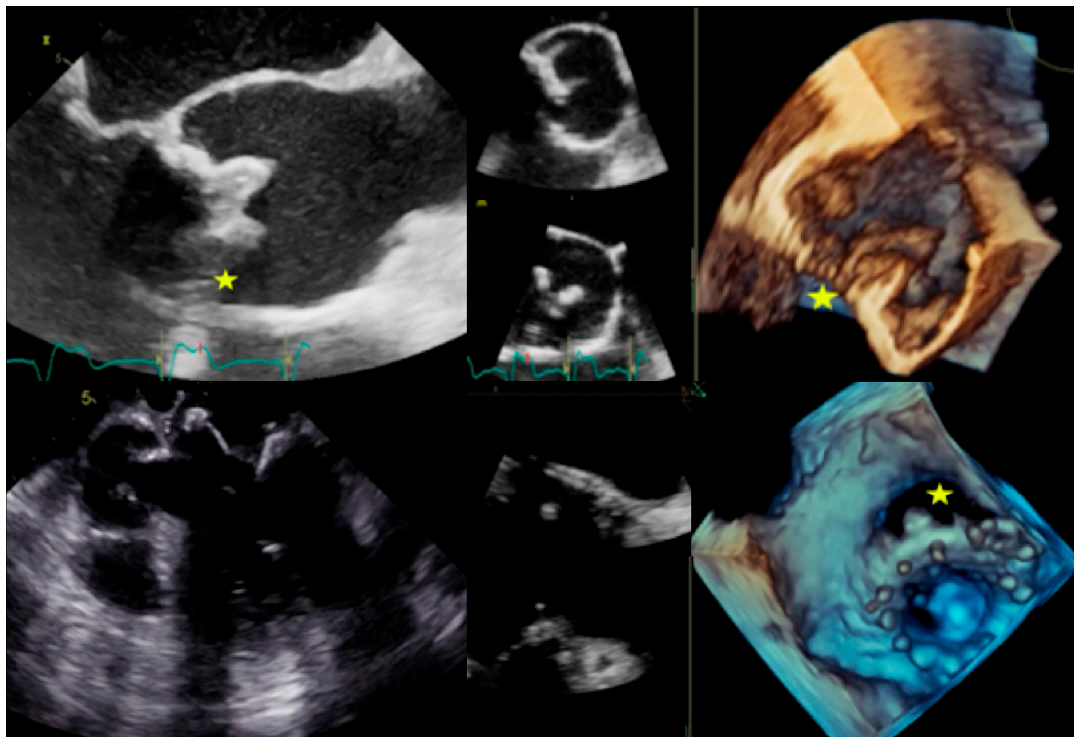
Figure 5. Complications of prosthetic valve endocarditis (PVE). Top: Biological prosthesis dehiscence in aortic position with large perivalvular leak (left: TOE long-axis view, right: 3D TOE view). Bottom: Biological prosthesis dehiscence in mitral position with large perivalvular leak (left: TOE long-axis view showing the direct communication between atrium and ventricle, right: 3D TOE view). Stars indicate the place of maximal prosthesis dehiscence.